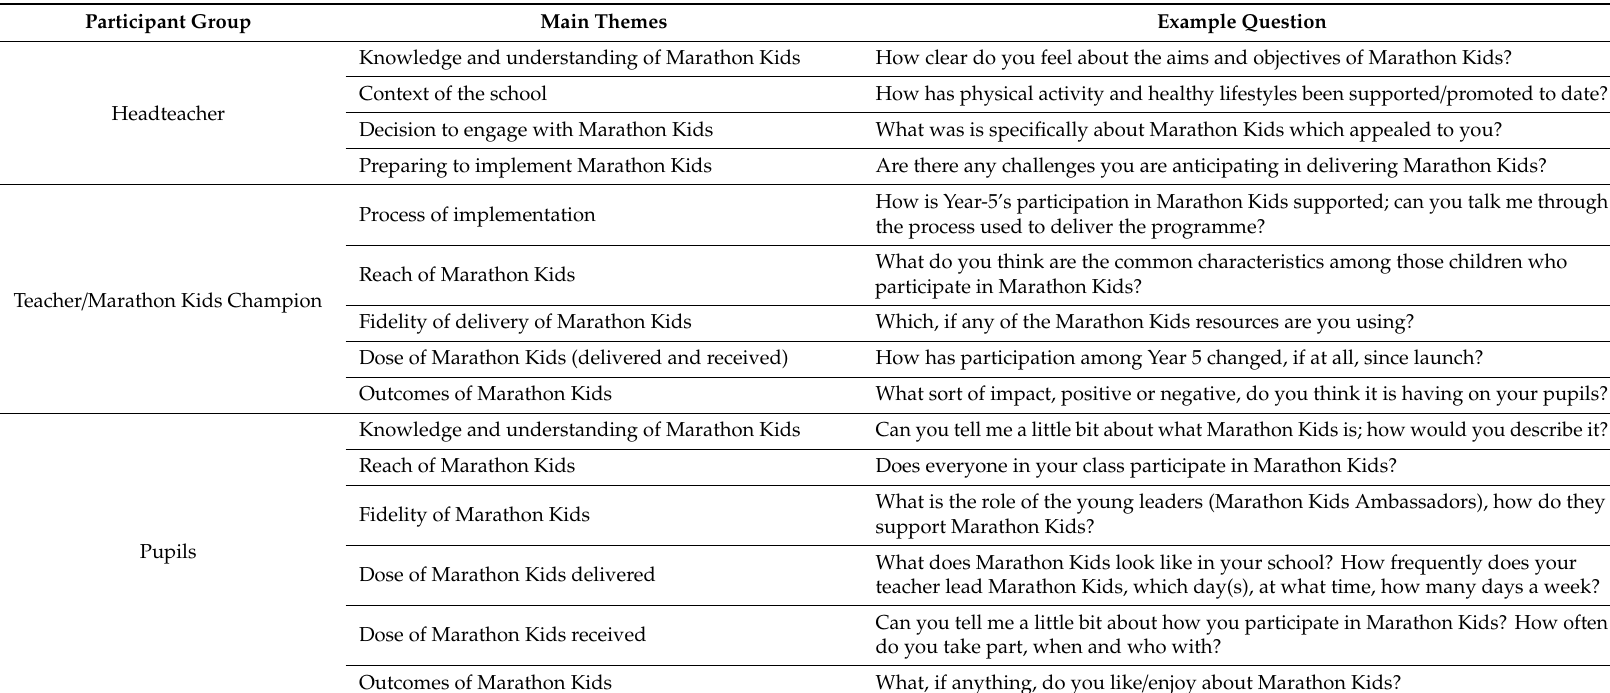
Table A2. Example thematic interview / focus group guide used for the